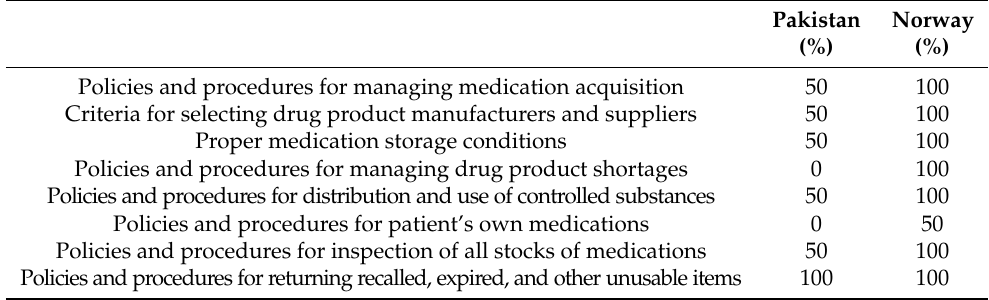
Table 6. Pharmacists’ assessments on drug product procurement and inventory